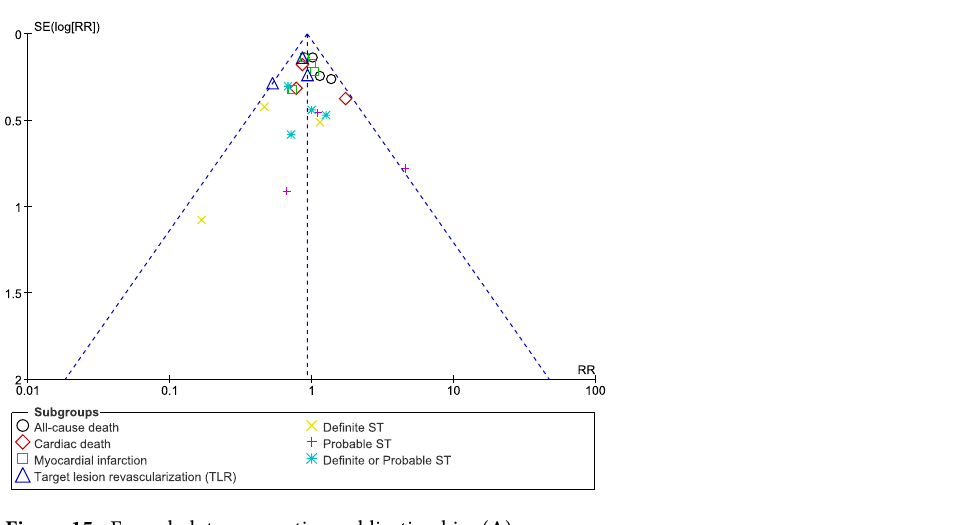
Figure 15. Funnel plot representing publication bias ( A